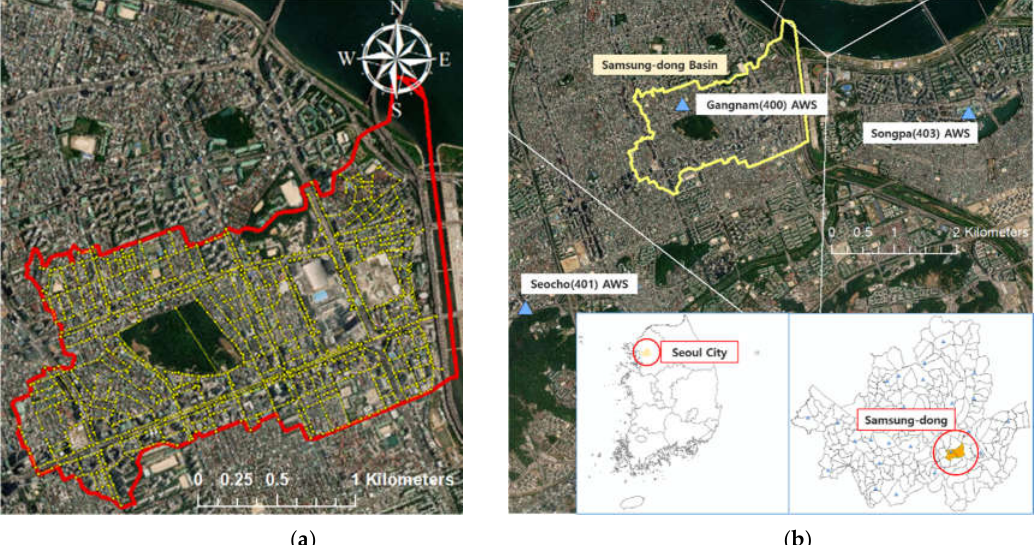
Figure 3. Study area and nearby Automatic Weather System (AWS) stations. ( a ) shows the drainage system, and ( b ) shows rainfall observatory.